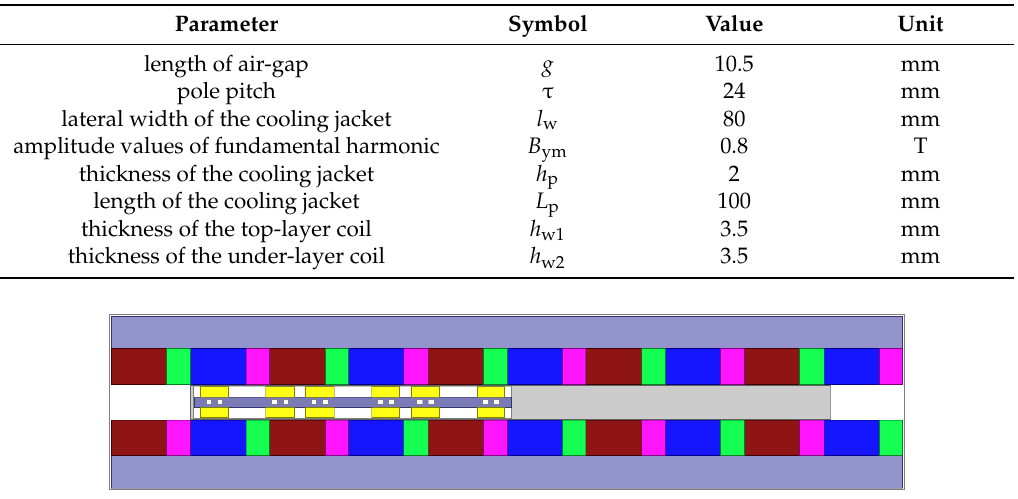
Figure 4. The finite element simulation model of the PMLSM.